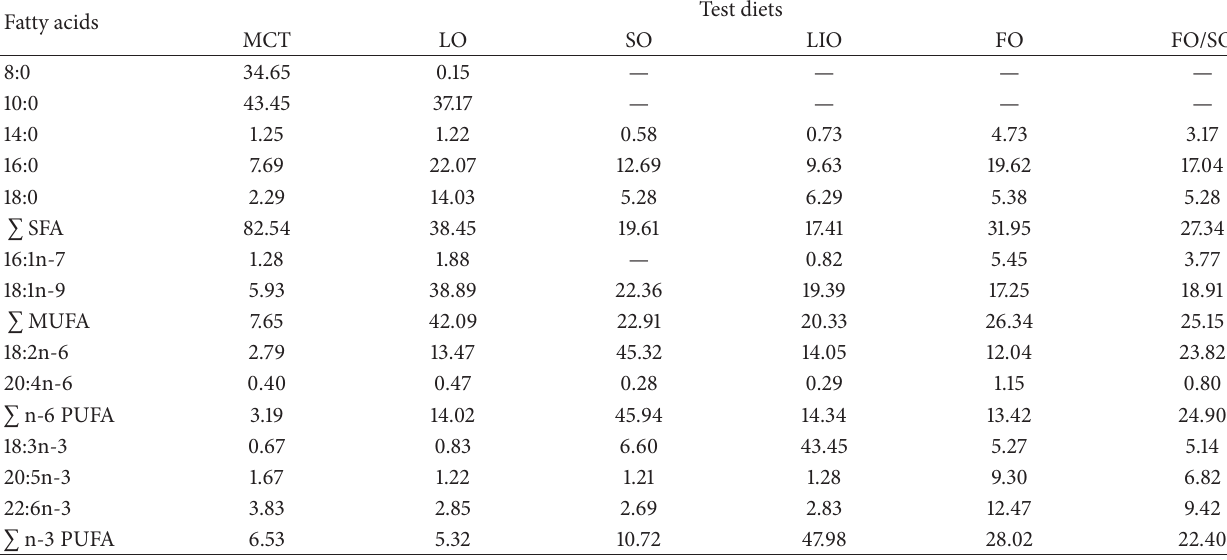
Table 2: Main fatty acid composition (% of total fatty acids) of experimental